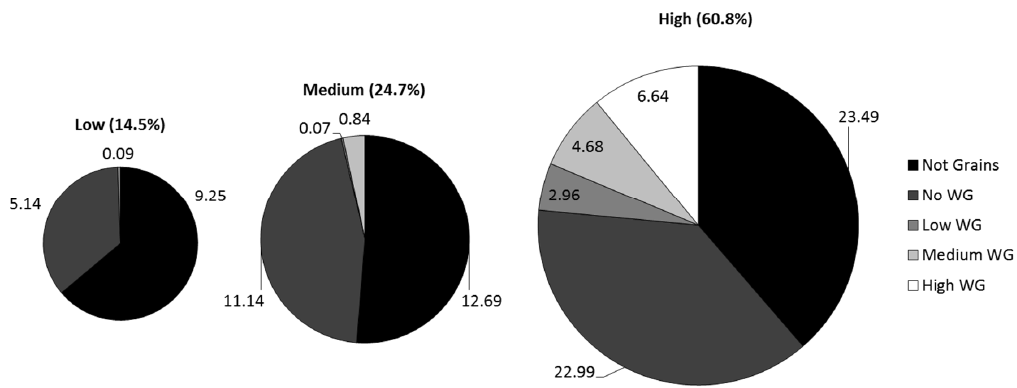
Figure 1. Percent of total dietary fiber intake provided by low, medium, and high fiber foods (defined by g fiber/100 g food) in the diets of Americans ages 2–85 years old.